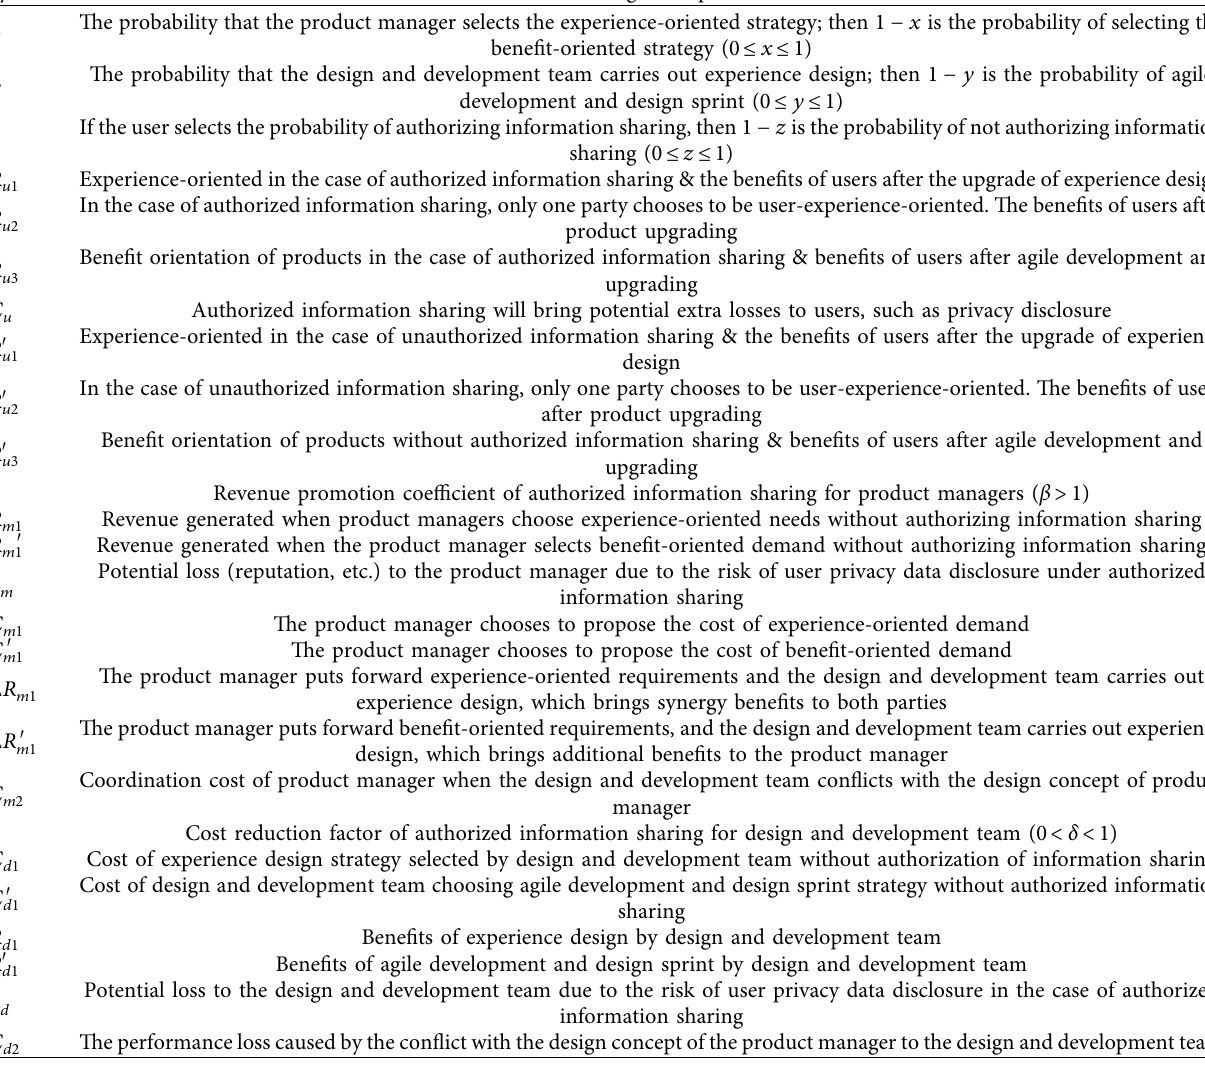
Table 1: The symbols and meaning